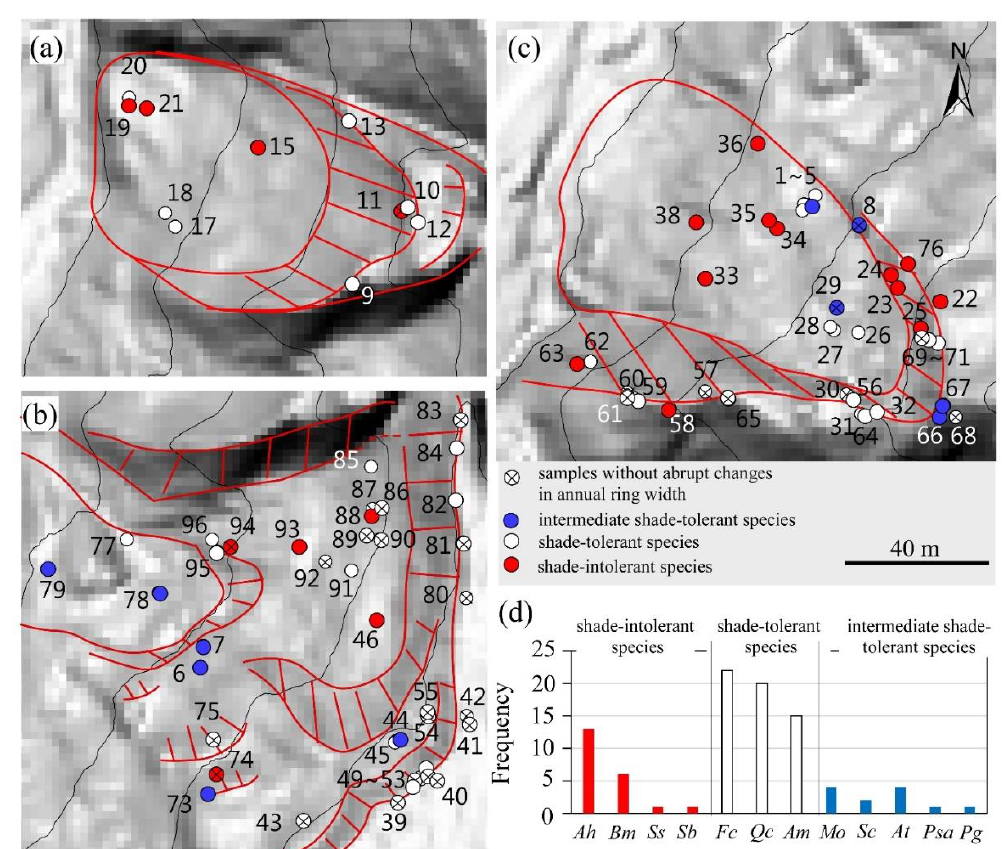
Figure 3. Locations of sampled trees and frequency distribution of tree species. ( a ) Locations of sampled trees at the N- Ohkawa landslide. ( b ) Locations of sampled trees in the eastern and northern sections of the Ohkawa landslide. ( c ) Locations of sampled trees in the southern section of the Ohkawa landslide. ( d ) Frequency distribution of tree species. The numbers on the maps are sample ID numbers.